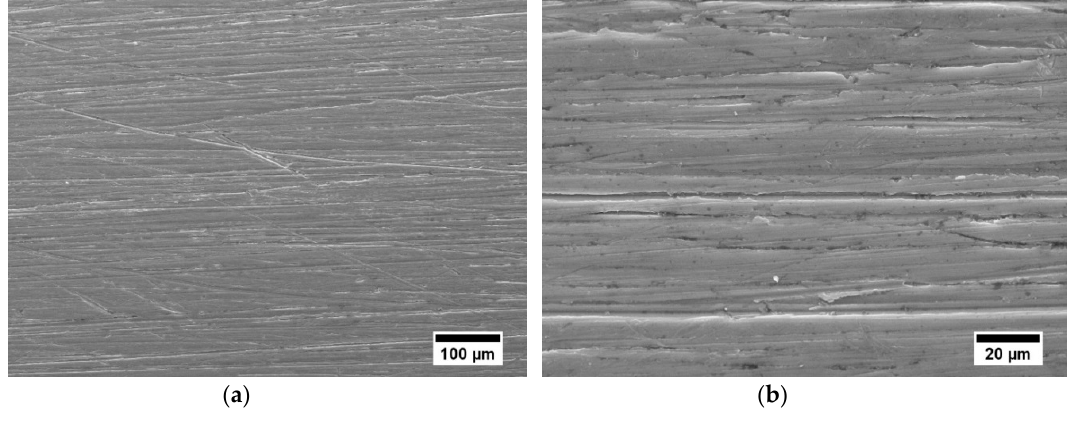
Figure 6. Surface morphology of the machined and polished (MP) specimens. ( a , b ) SEM views of the top surface.